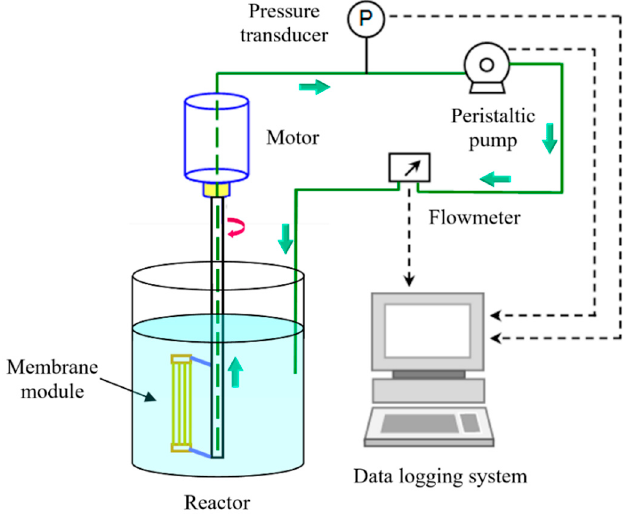
Figure 1. Schematic diagram of the experimental setup.